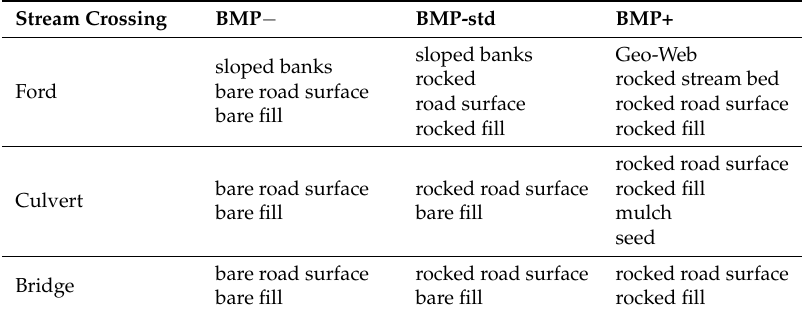
Table 2. BMP treatment description by crossing type. Rock on road surface is #357 (1.90–2.54 cm) stone; rock in stream bed (used in Geo-Web) is VDOT #5 (1.25–5 cm) stone; and rock on fill slopes is #3-0 (approximately 10–30 cm)